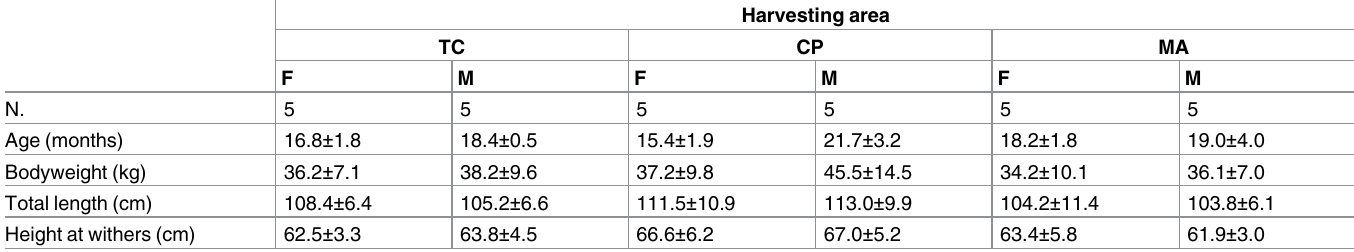
Table 2. Morphological traits (mean ± SD) of female (F) and male (M) wild boars included in the trial according to harvesting area (TC = Tyrrhenian Coast; MA = Maremma, CP = Central plains) and